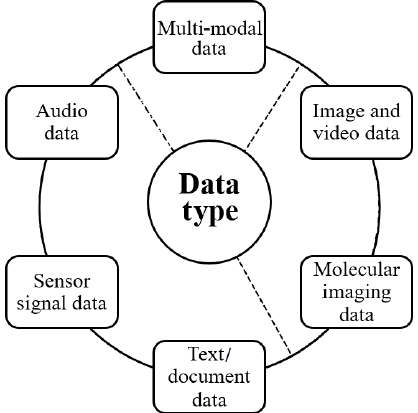
Fig. 3 Common data types of the nuclear industry chain. Among them, the audio data, sensor signal data, and text/document data can be divided into sequence data. The image and video data, and molecular imaging data belong to visual image data. The multi-modal data refers to data from multiple sources or